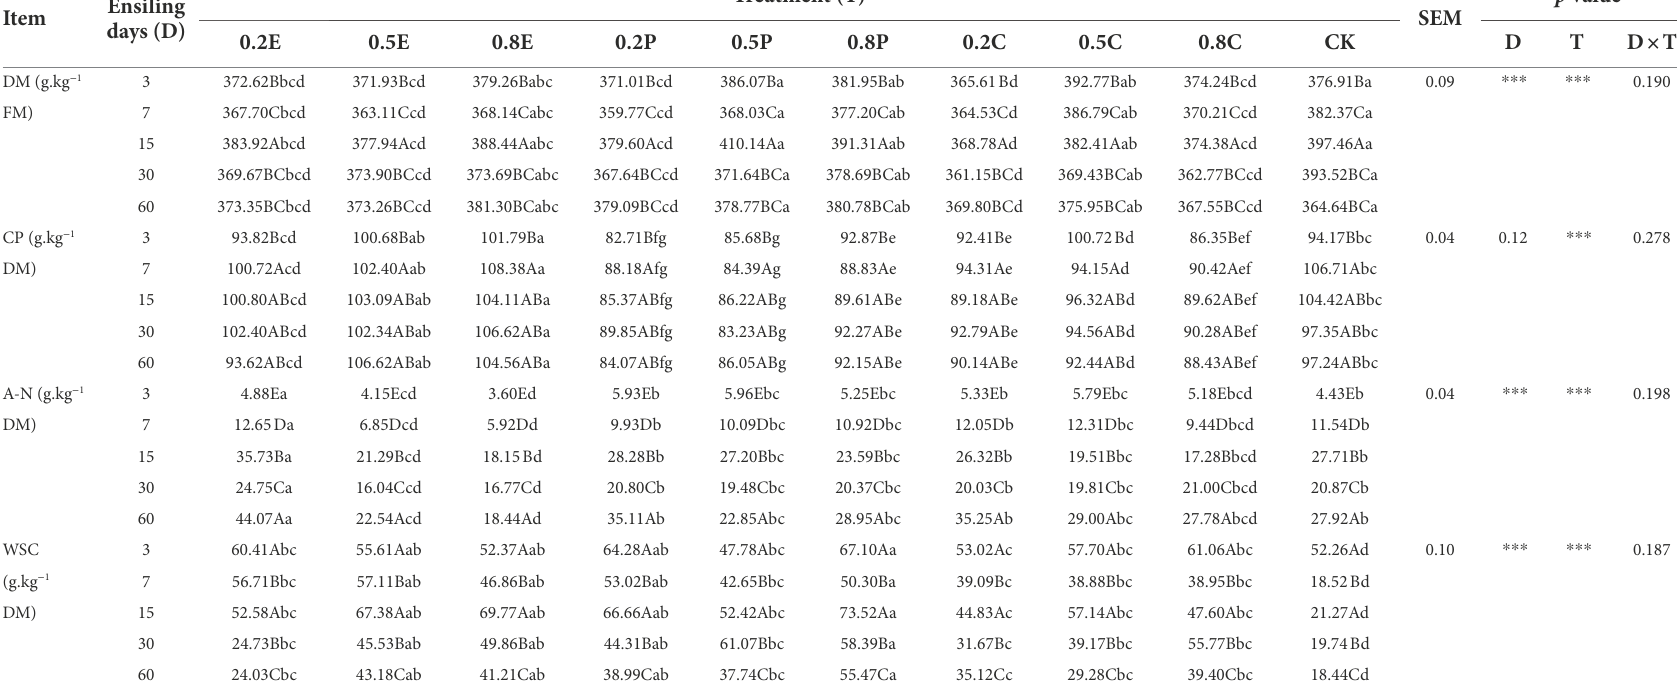
TABLE 3 Chemical characterization of paper mulberry ensiled with different treatment during